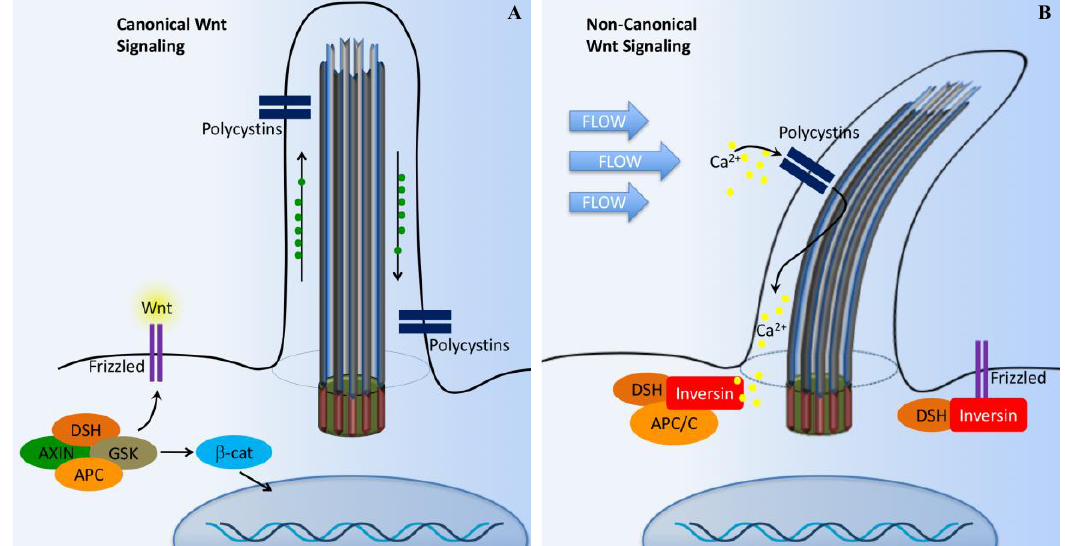
Figure 4. Cilia-dependent Wnt signaling. The cilia/basal body may function as a regulatory switch to control the canonical and non-canonical Wnt signaling pathways. ( A ) In the absence of fluid flow, canonical Wnt signaling predominates. Wnt ligand binds to the co-receptors frizzled, dishevelled (DSH) is recruited to frizzled, and glycogen synthase kinase-3 (GSK3) is inactivated. β-catenin (β-cat) translocates to the nucleus, where it acts as a transcriptional co-activator with members of the LEF and TCF family and induces transcription of Wnt target genes such as cMYC, AXIN2, or L1CAM. ( B ) In non-canonical Wnt signaling, the mechanosensation by fluid flow causes intracellular Ca 2+ increase and an increase inversin expression. Inversin resides in multiple locations in the cell as well as at the base of the cilium. Inversin targets cytoplasmic DSH for anaphase-promoting complex/cyclosome (APC/C)-dependent ubiquitylation and degradation, making it unavailable for canonical Wnt signaling.